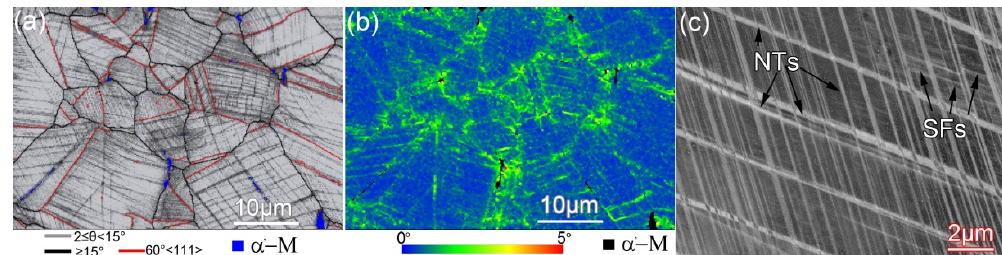
Figure 3. EBSD results showing deformation twins and stacking faults (SFs) at the surface layer of the sample twisted for 100 cycles at 10°/min. ( a ) GB map, ( b ) KAM map, and ( c ) ECCI image.